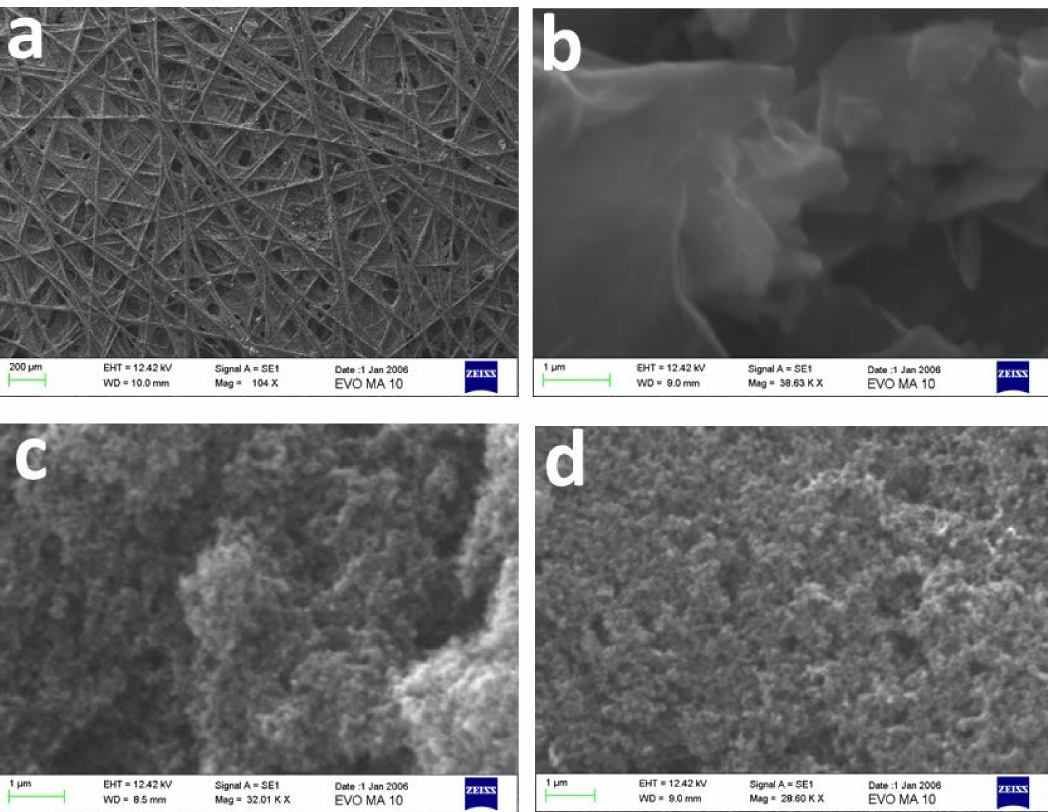
Figure 3. SEM images of the carbon paper used in this work: ( a ) plain and ( b – d ) covered with various electrocatalysts: ( b ) reduced graphene oxide (RGO); ( c ) carbon black; and ( d ) carbon black and Pt. The scale bar is 200 µ m in ( a ) and 1 µ m in ( b – d